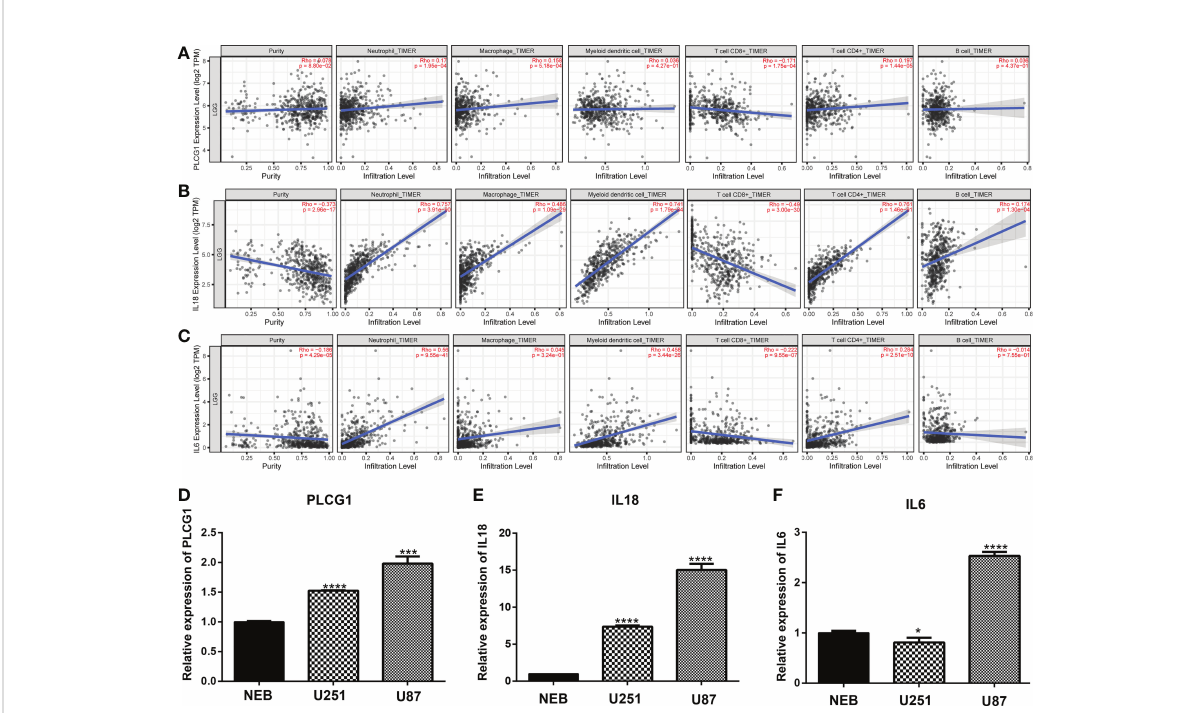
FIGURE 7 Expression of pyroptosis-related genes in immune cells and cell lines. (A-C) Association between the abundance of immune cells and the expression of three pyroptosis-related genes for PLCG1 (A) , IL18 (B) , and IL6 (D) . (D-F) . Quantitative Real-time PCR in cell lines for PLCG1 (D) , IL18 (E) , and IL6 (F) . ∗ P< 0.05; ∗∗∗ P< 0.001; ∗∗∗∗ P<